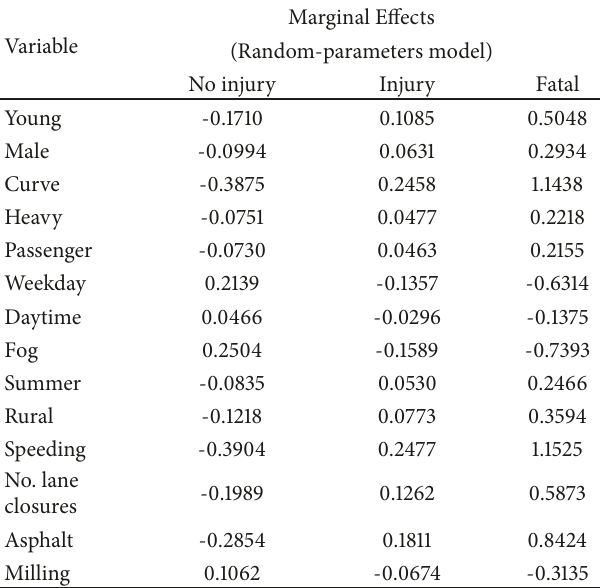
Table 3: Marginal effects associated with the random-parameters